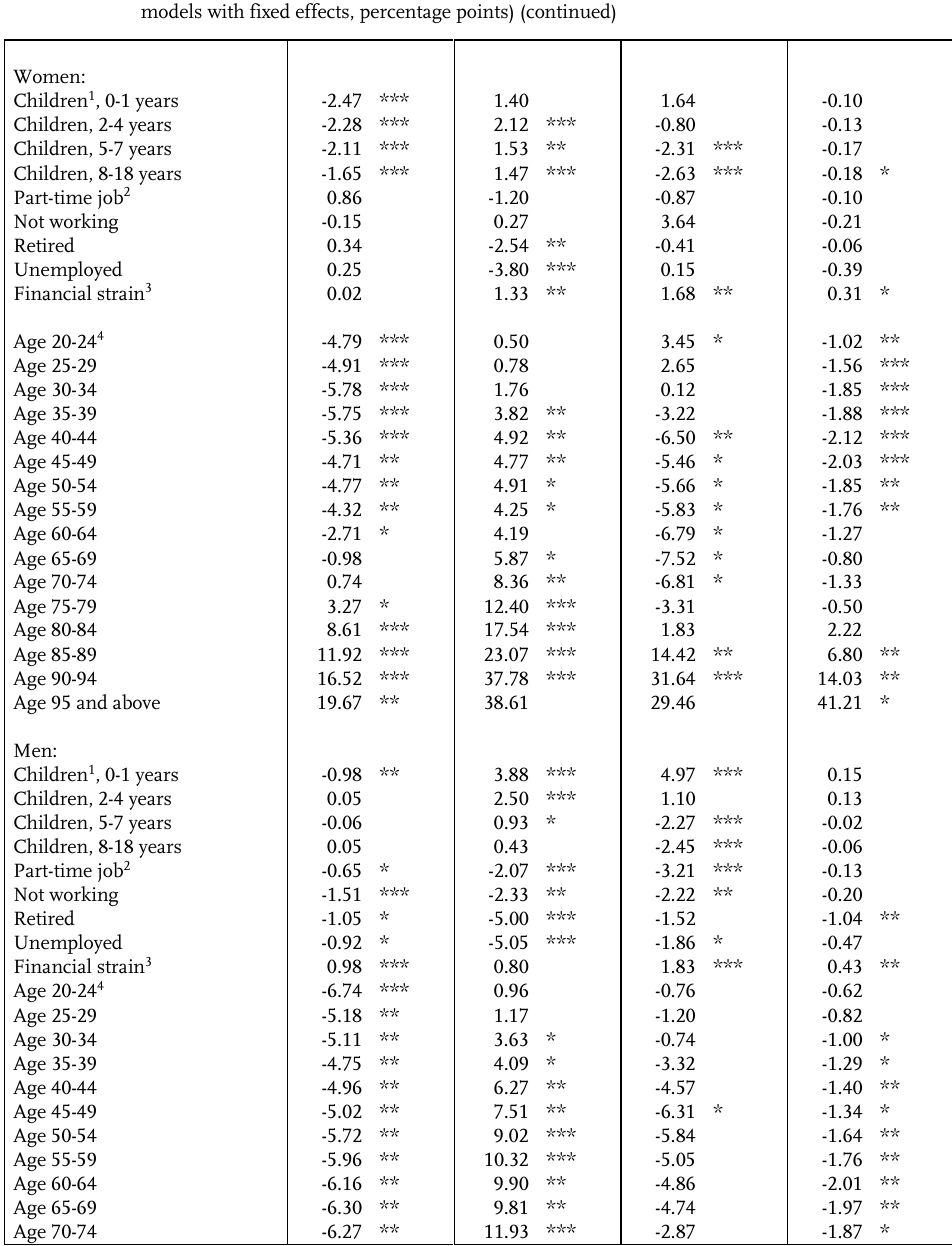
Table A.7 : Time-effects of relationship endings on different types of social isolation (from linear-probability models with fixed effects, percentage points)